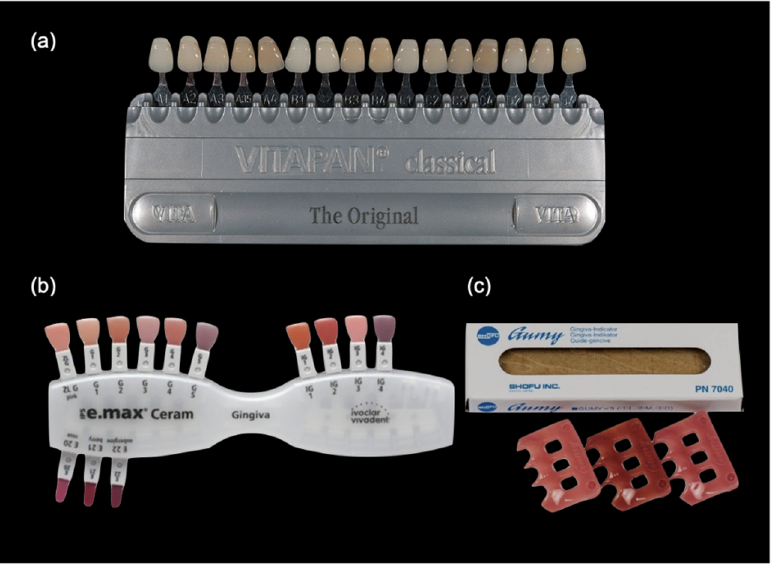
Figure 1. Dental shade guides. ( a ) VITA classical shade guide (Germany); ( b ) IPS e.max Ceram Gingiva Shade (Lichtenstein); ( c ) Shofu gingival shade guide (Japan).